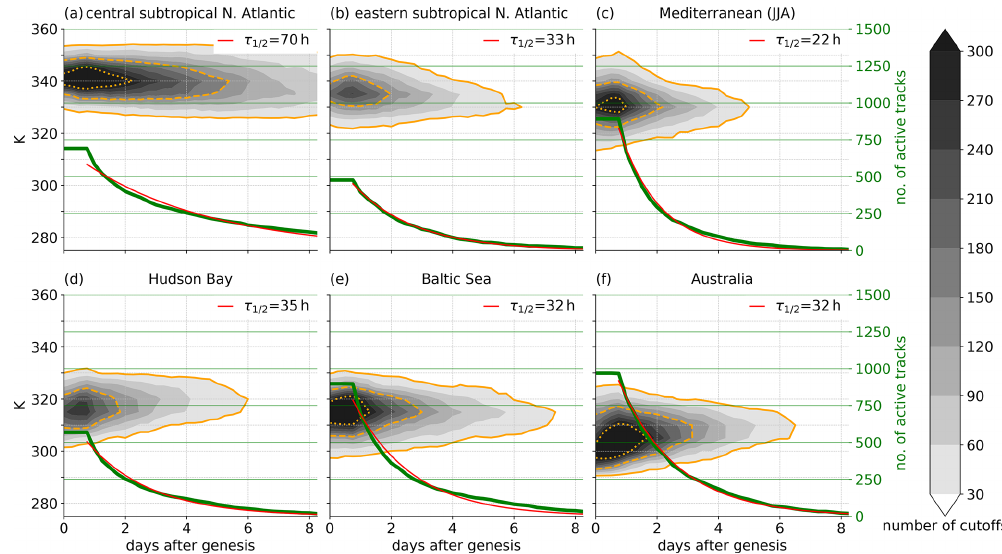
Figure 13. Same as Fig. 12 but for JJA and (a) central subtropical North Atlantic, (b) eastern subtropical North Atlantic, (c) Mediterranean, (d) Hudson Bay, (e) Baltic Sea, and (f)